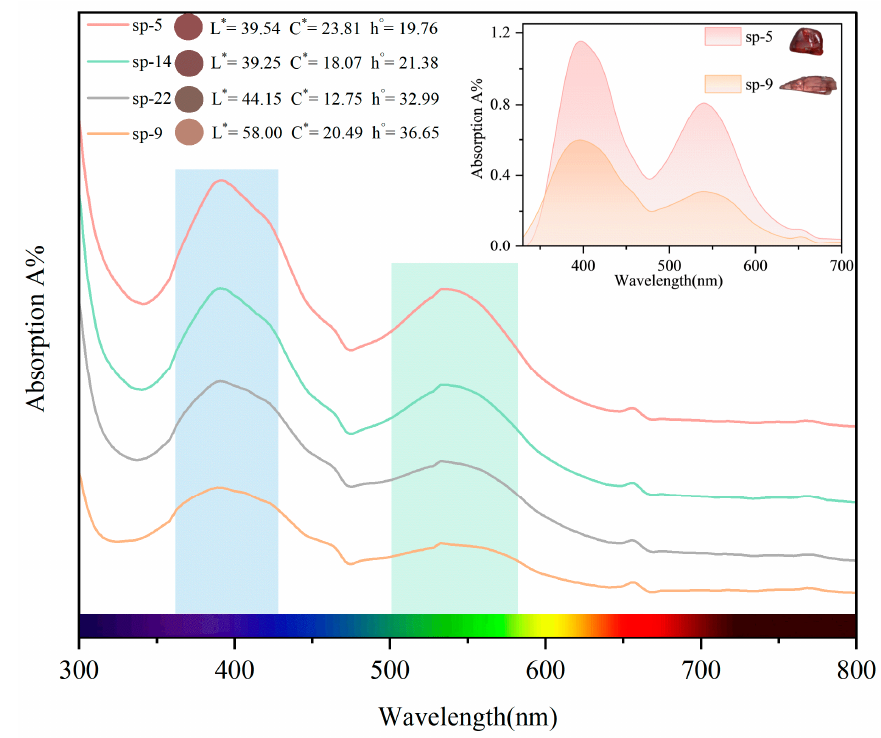
Figure 7. UV-Vis absorption spectra of chromium–vanadium-bearing spinel.